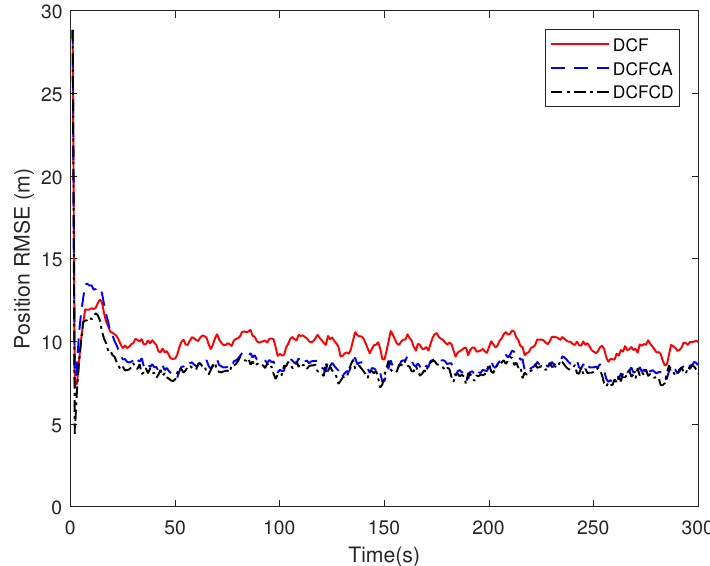
Figure 5. The position RMSE for different methods over time with global observability.